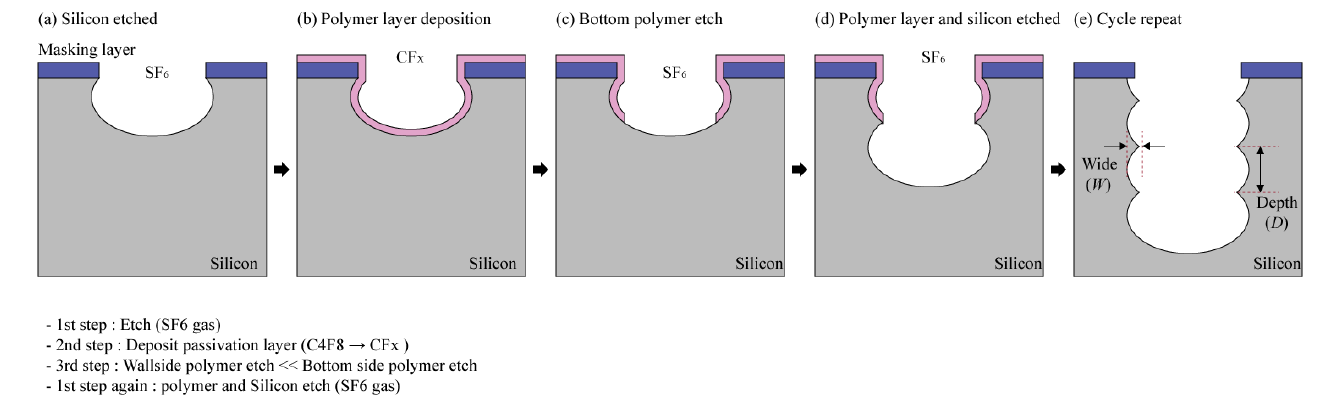
Figure 4. Schematic picture of steps in the Bosch process and the scallops formed.